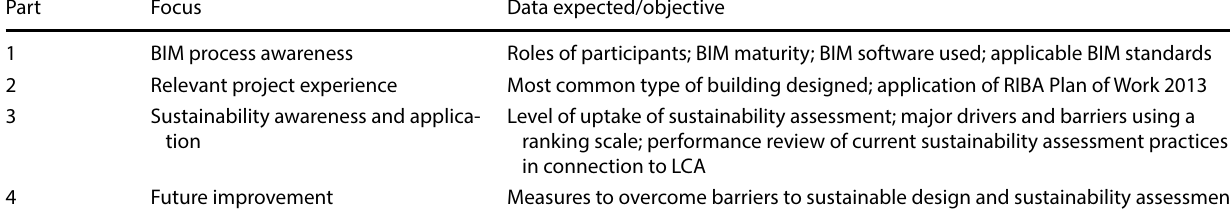
Table 3 Outline of survey questionnaire Part